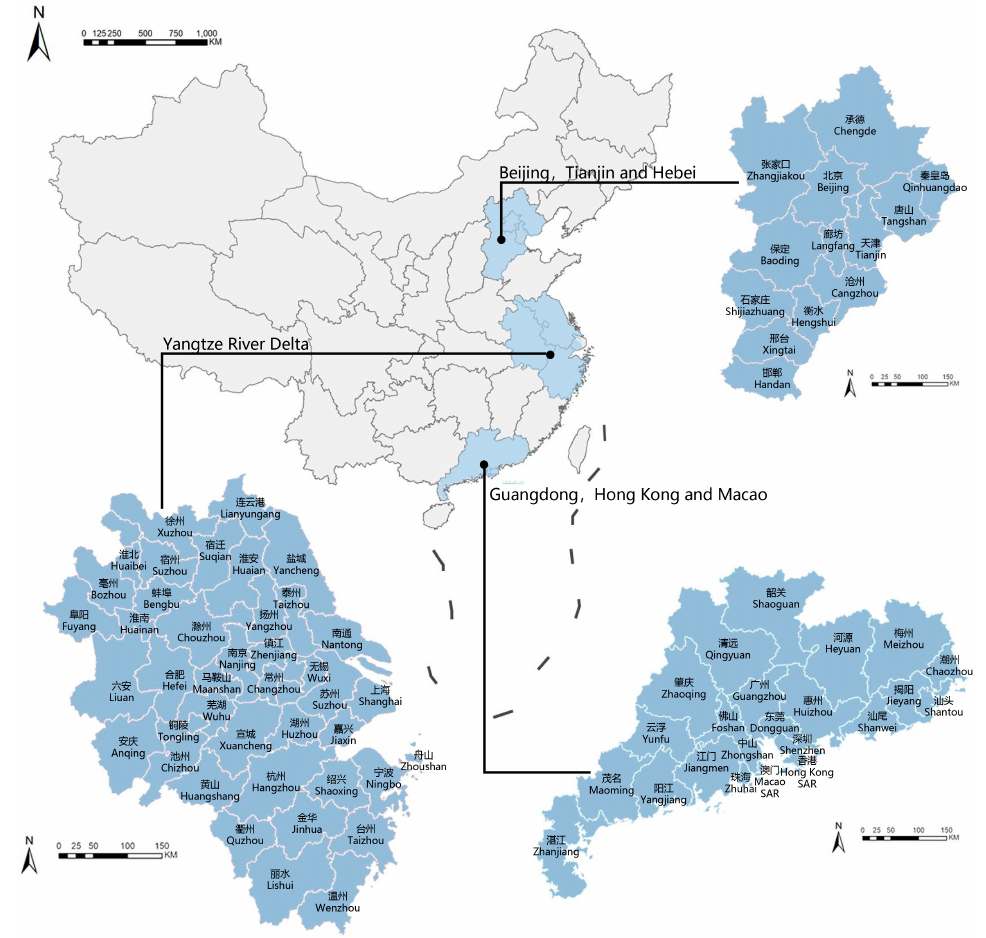
Figure 1. The location of three megacity regions in China.